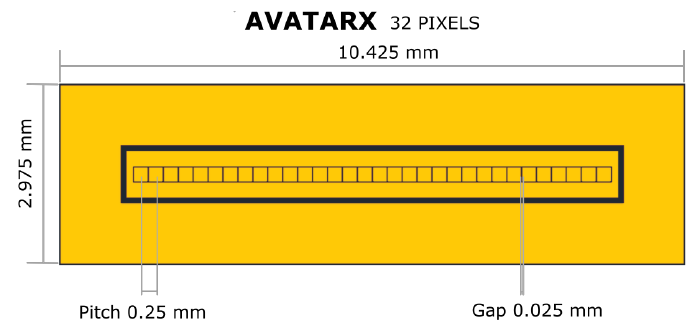
Figure 1. Geometry of the CZT linear array. An inner guard ring is present that can be connected to a dedicated read-out channel to allow charge sharing corrections.